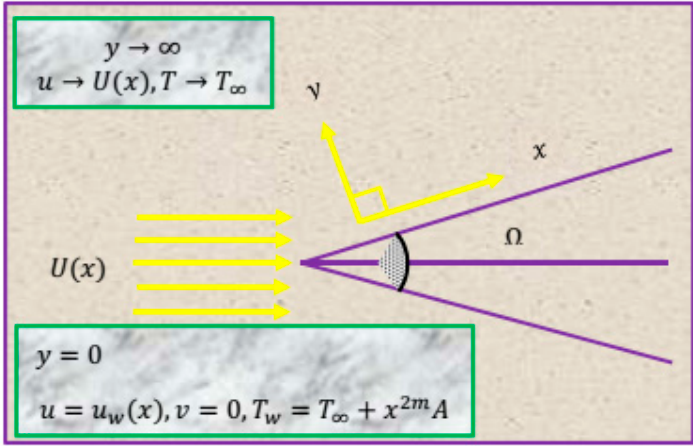
Figure 1. Flow Configuration and Coordinates.